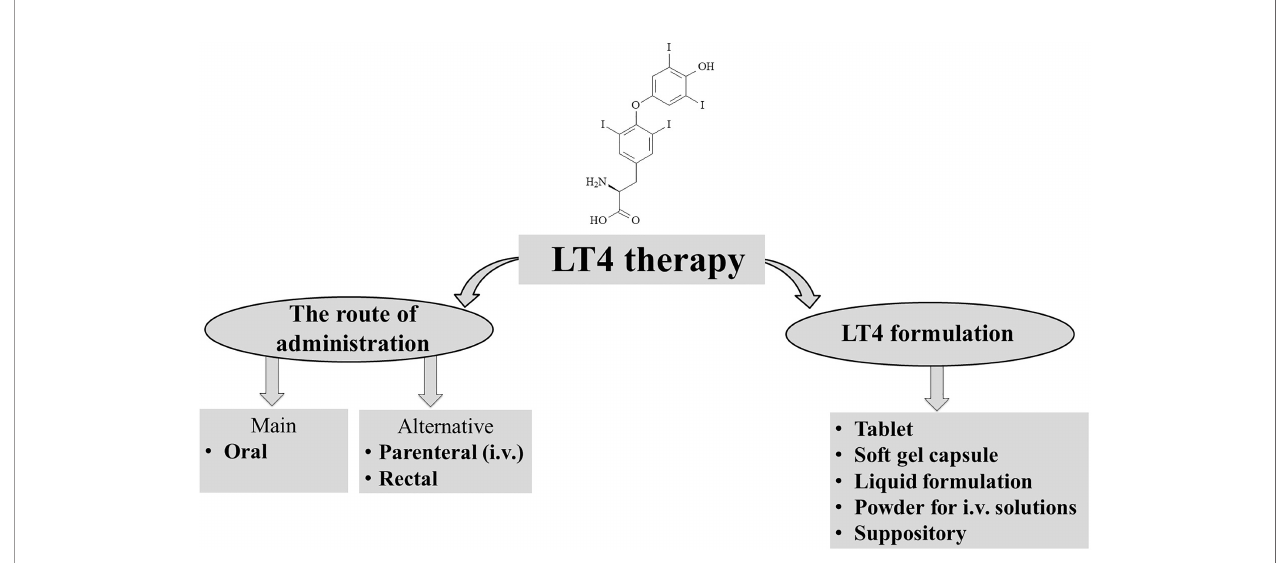
FIGURE 1 | Levothyroxin (LT4)